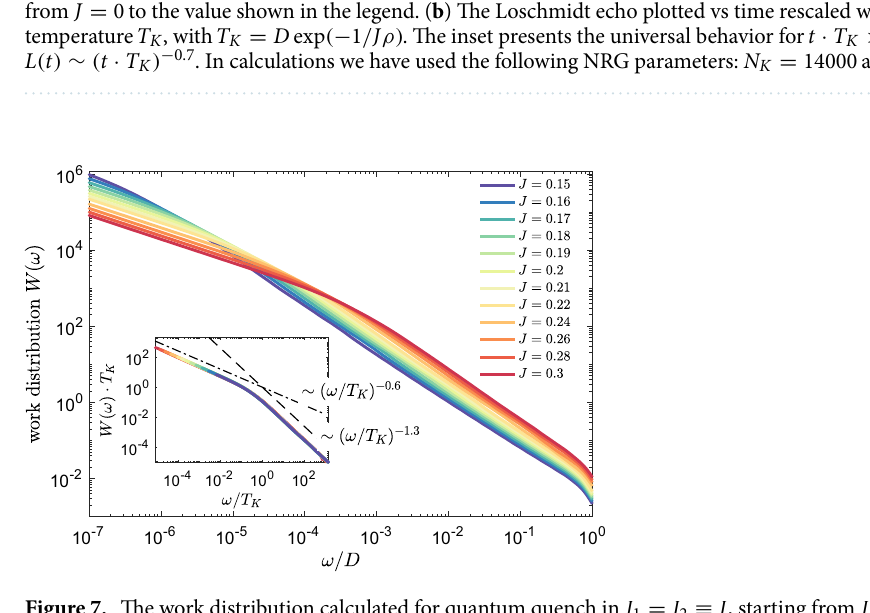
Figure 7. The work distribution calculated for quantum quench in J 1 = J 2 ≡ J , starting from J = 0 to the value shown in the legend. The inset presents the rescaled work distribution W (ω) · T K plotted as a function of ω/ T K . We find the scaling W (ω) ∼ ω − 0.6 , for ω < T K , and W (ω) ∼ ω − 1.3 , for ω > T K . The other parameters are the same as in Fig.